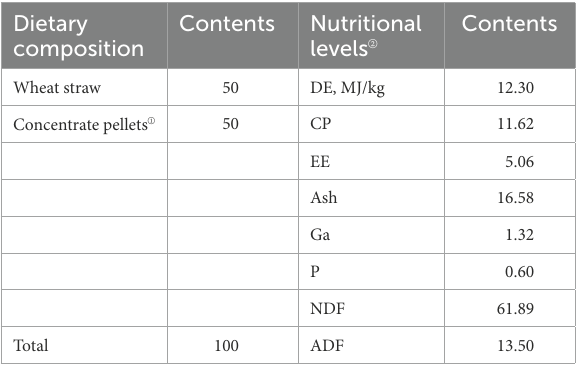
TABLE 1 Experimental diet composition and nutritional level (DM basis)